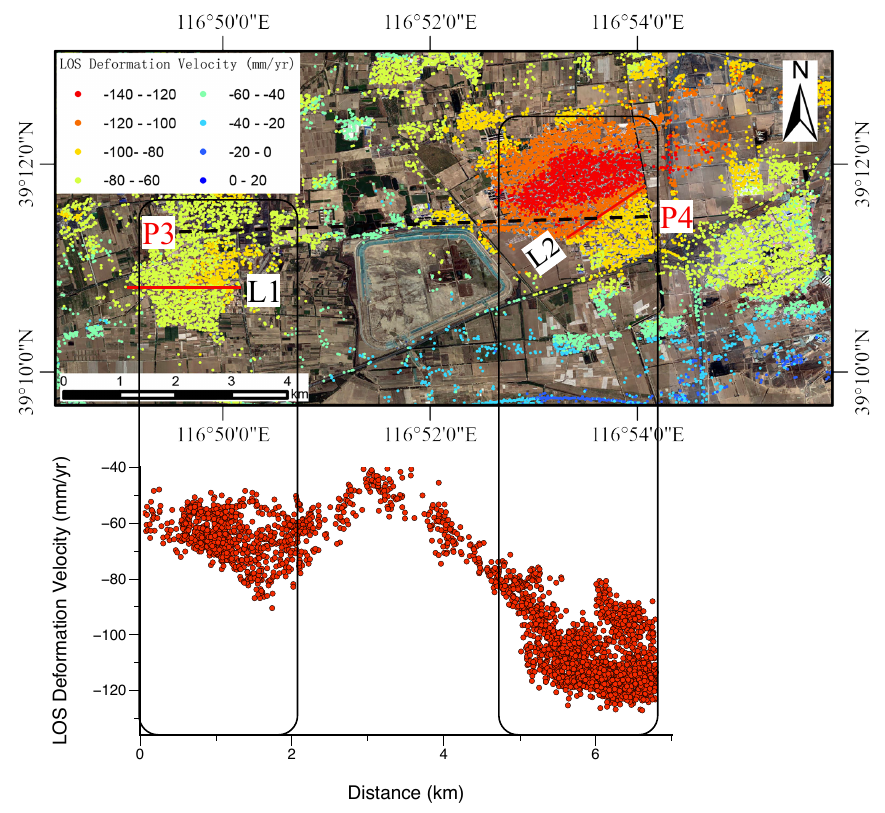
Figure 16. The mean LOS deformation velocity map of Shengfang Town and Wangqingtuo Town: The black dotted line from point P3 to P4 represent the profile of the Jintong